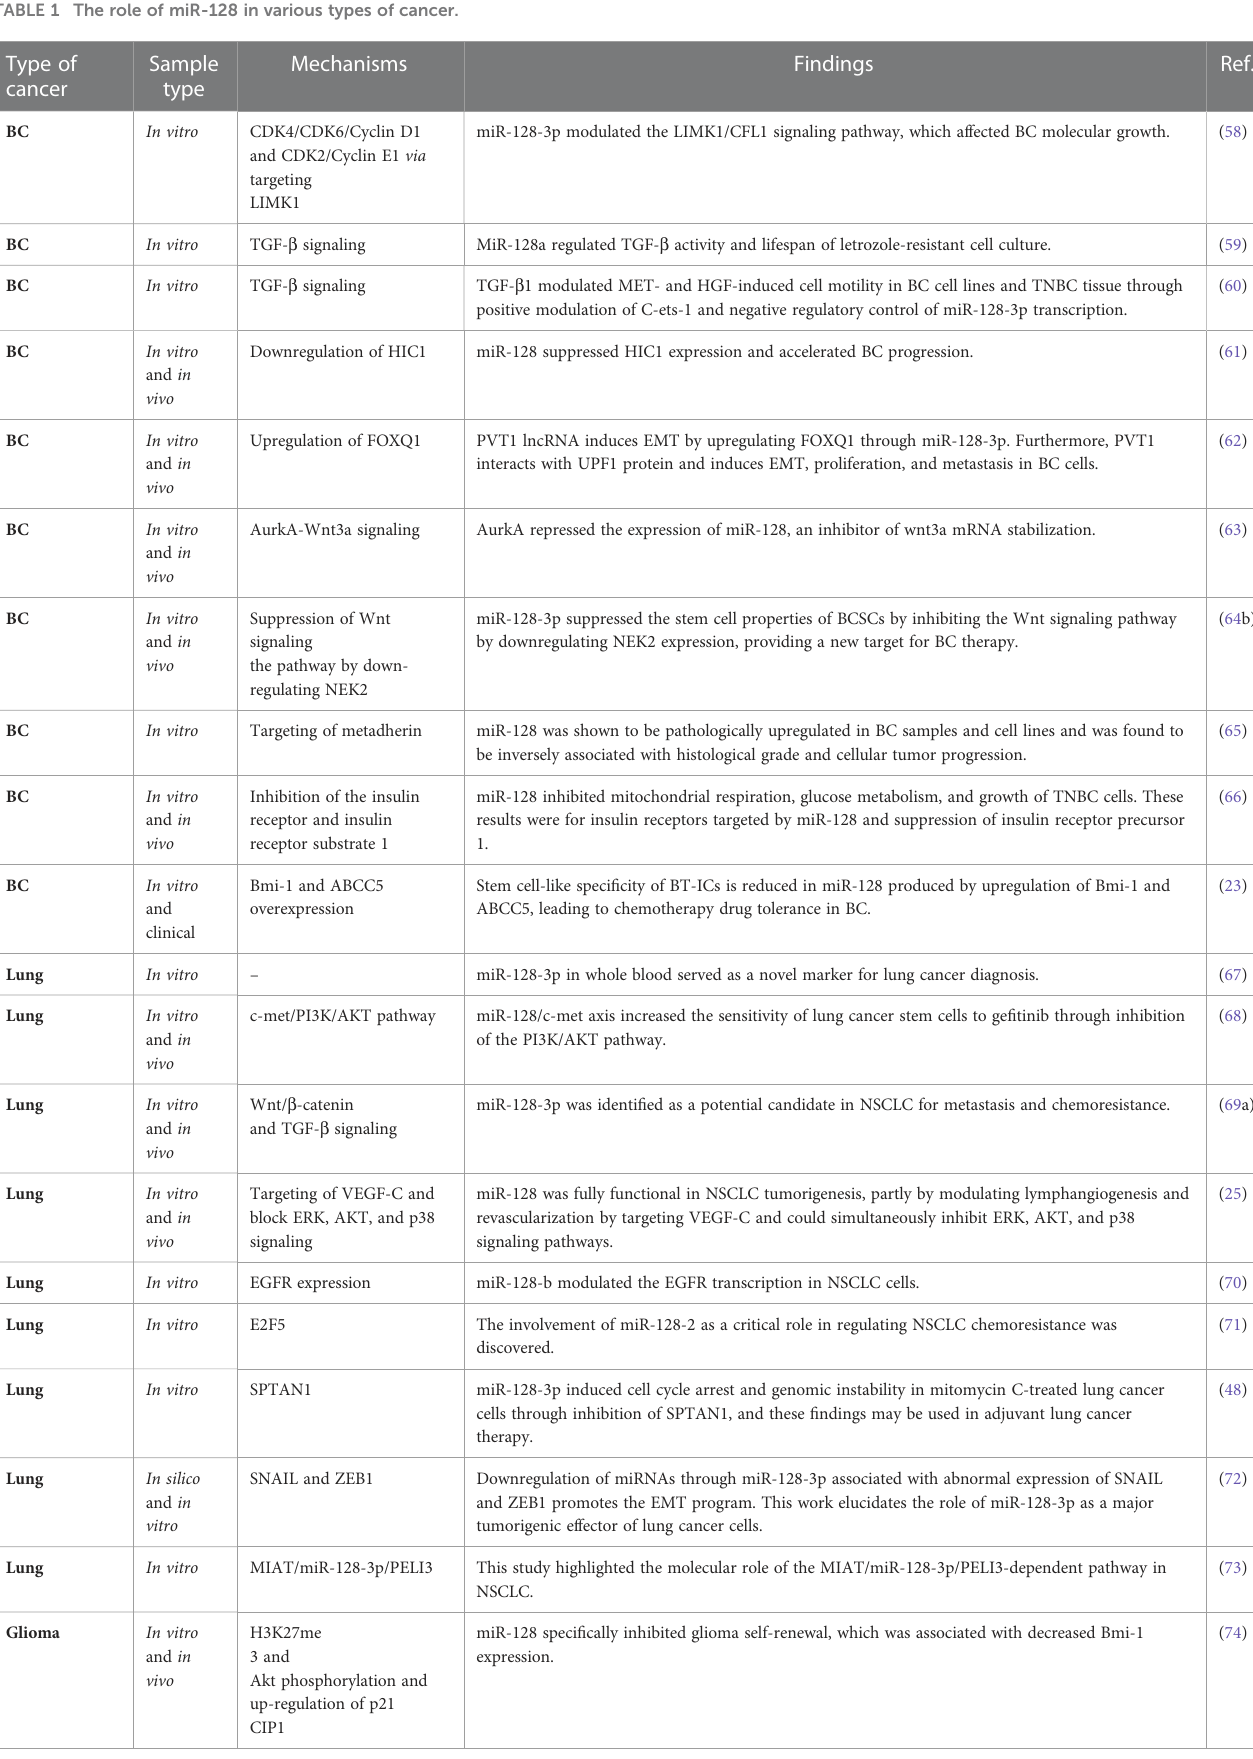
TABLE 1 The role of miR-128 in various types of cancer. Type of Sample cancer